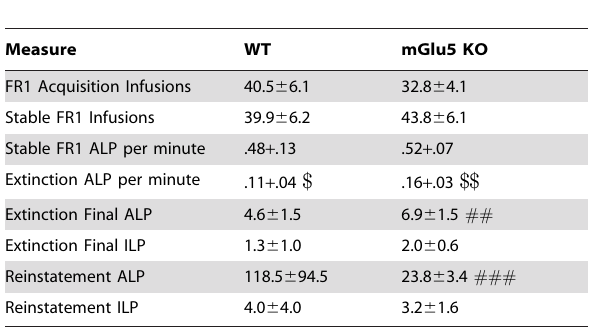
Table 1. Lever Responses and Infusions during METH IVSA FR1 Acquisition, Self-administration, Extinction and